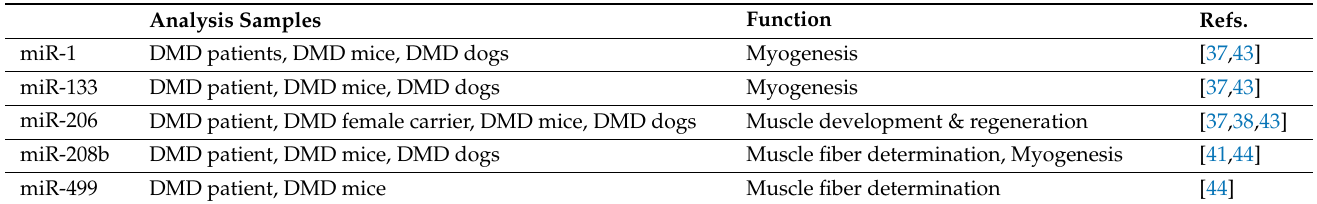
Table 2. Muscle-enriched miRNAs elevated in dystrophic